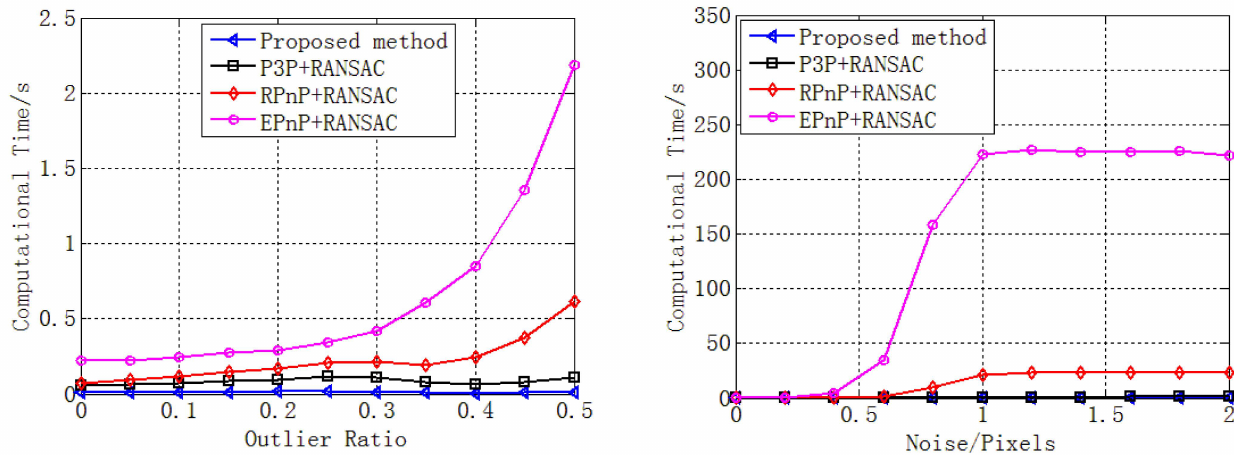
Figure 10. Computational time under different noise ( left ) and outlier ratio ( right ) levels for our proposed method (blue), P3P + RANSAC (black), RPnP + RANSAC (red), and EPnP + RANSAC